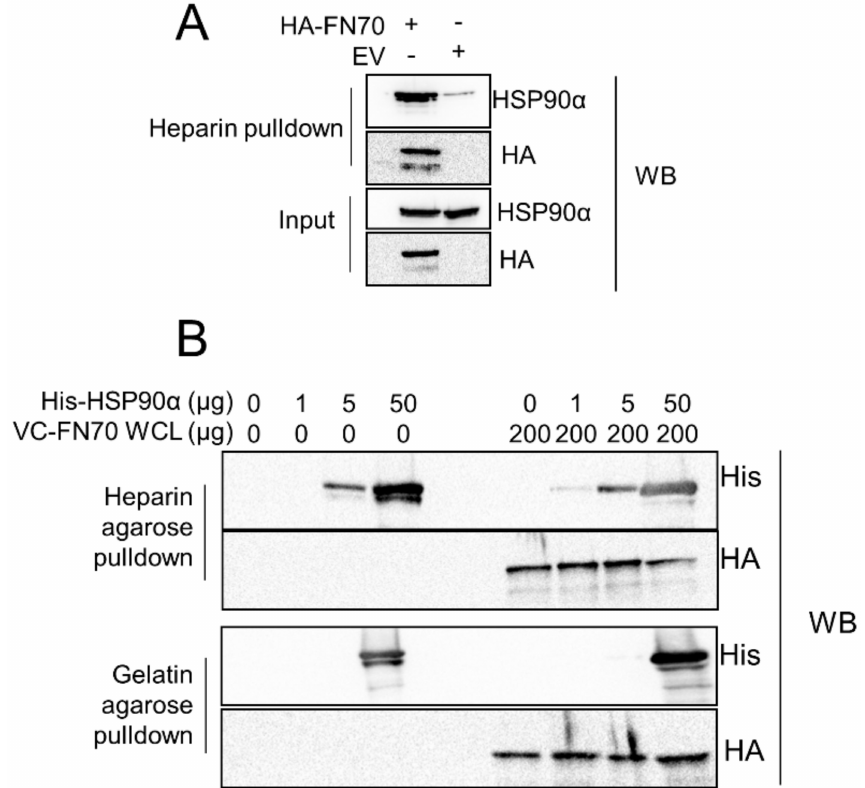
Figure 5. FN interaction with HSP90 and heparin is not mutually exclusive. ( A ) FN70 and HSP90 interaction in the presence of heparin and gelatin. ( B ) Heparin (upper panel) and gelatin (lower panel) agarose pull-down assay using whole cell lysate (WCL) from HEK293T cells transfected with VC-FN70 and exogenous recombinant purified His-HSP90 α . Complexes were analyzed by western blot with an anti-HA antibody to detect VC-FN70 and an anti-His antibody to detect His-HSP90 α . Data shown are representative of two independent